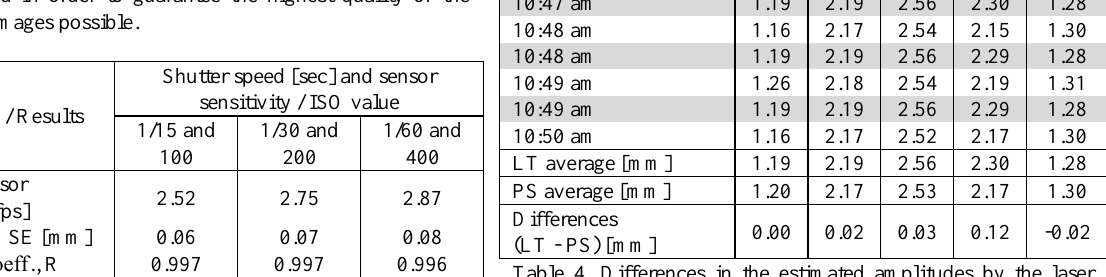
Table 4. Differences in the estimated amplitudes by the laser transducers (LT in grey) and the photogrammetric system (PS in white) at five of the 13 offset witness